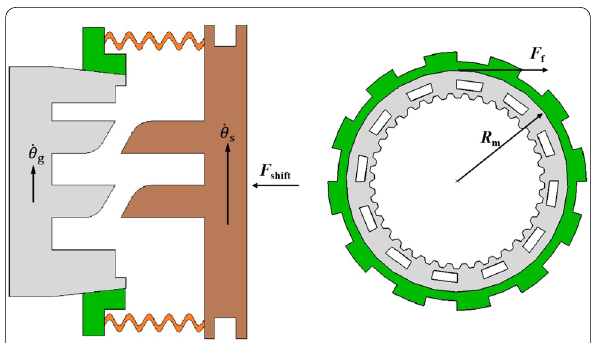
Figure 14 Schematic diagram of the synchronization process of the synchro ring and the friction cone ring contacting